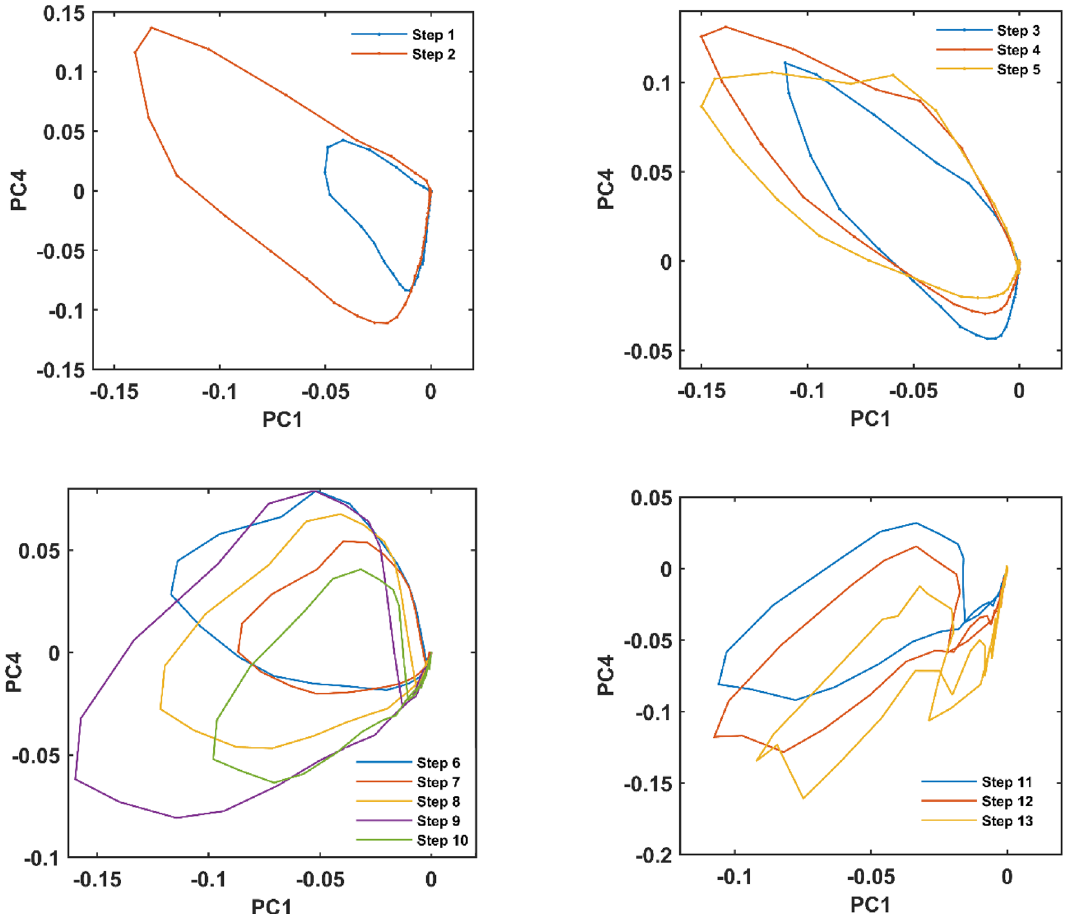
Figure 4. Trajectories for the thirteen EEM fluorescence images from different steps of dilution of CNDs which shows the increase in EEM signal variation (Figure S4). For the third to the fifth step (Fig. 2a), due to the appearance of new fluorescent components, there are similar trajectory patterns that reveal the small changes in the EEM characteristics of the solutions. The violet profile (Fig. 2a) rising at the sixth step, leading the shape of emission trajectories for the following steps. The total decrease of EEM fluorescence intensity in the seventh step resulted in its smaller pattern, compared to that in the sixth step. The evolution of patterns was almost finished at the eighth step, and after that, there are similar emission trajectories for the dilution process. These similar